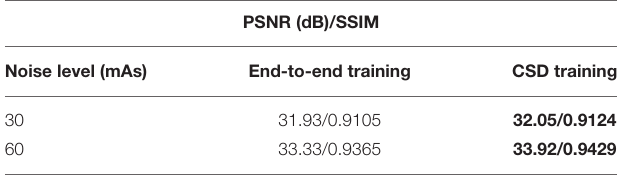
The best results are highlighted in